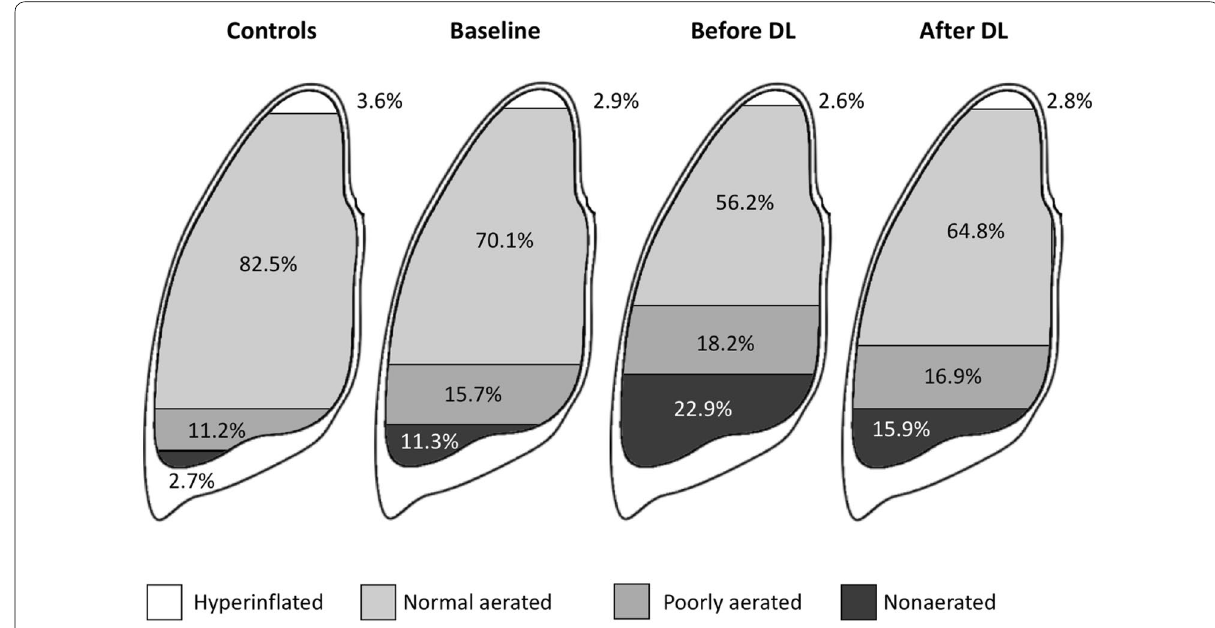
Fig. 2 Effect of abdominal hypertension and decompressive laparotomy (DL) on total lung volumes expressed percentages of different aerated lung volumes. Adapted from Zhou et al.